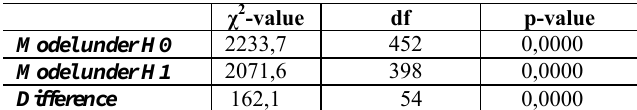
Table 5: Overall model cross-validation: Chi-square difference test results